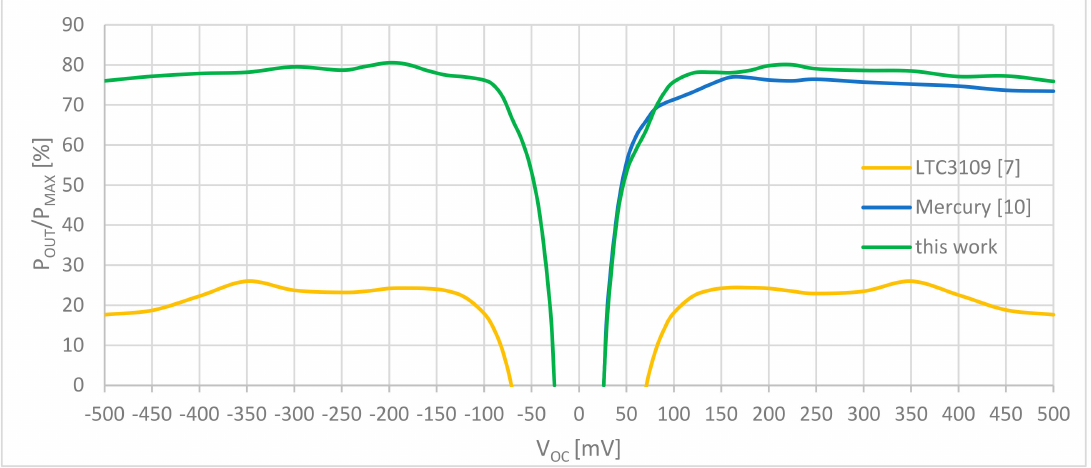
Figure 9. E ffi ciency vs. V OC for R TEG = 12 Ω and V OUT = 4.2